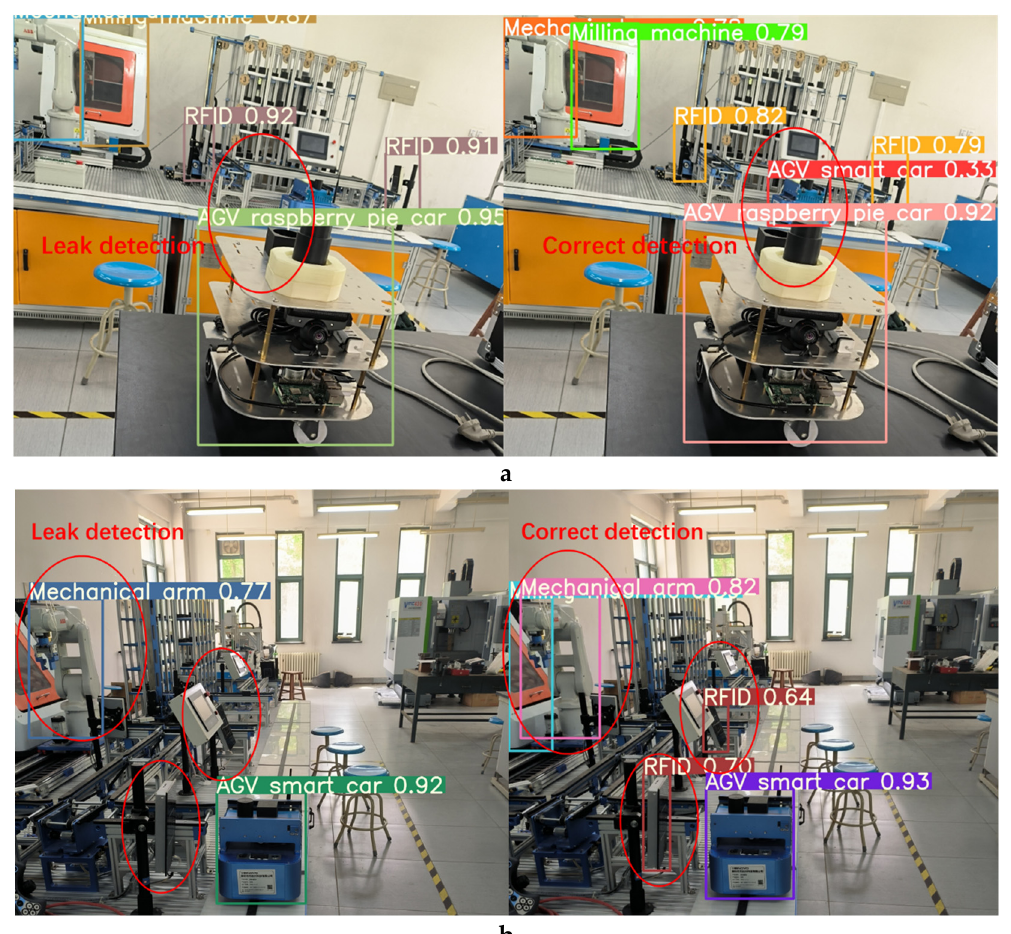
Figure 16. Comparison of recognition test results between YOLOv5-Lite and the improved method.